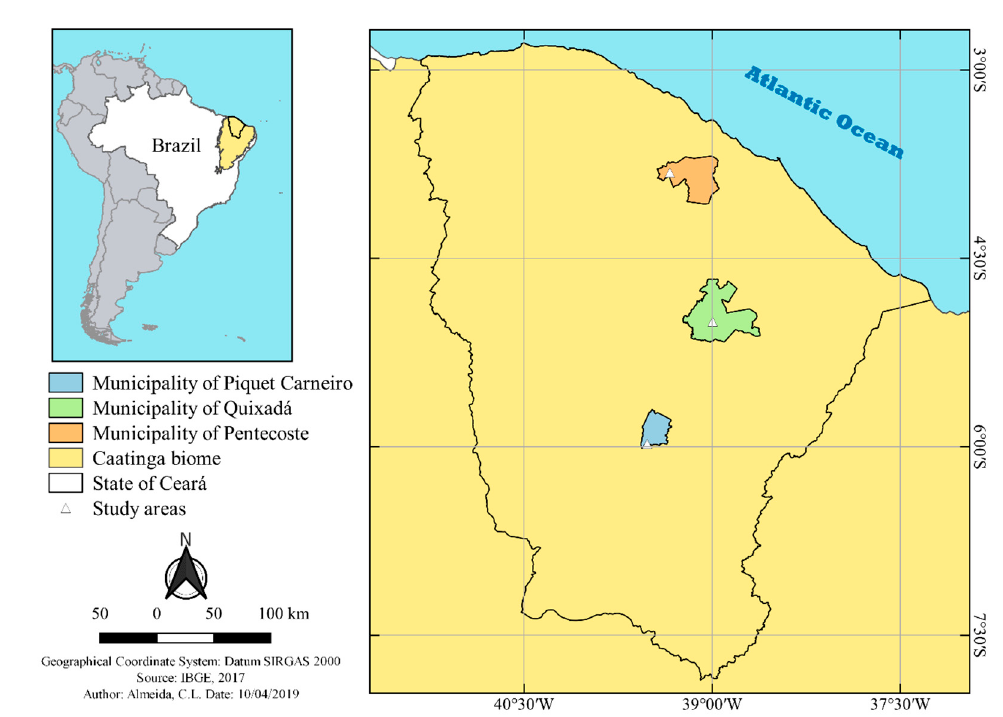
Figure 1. Location of the study sites.